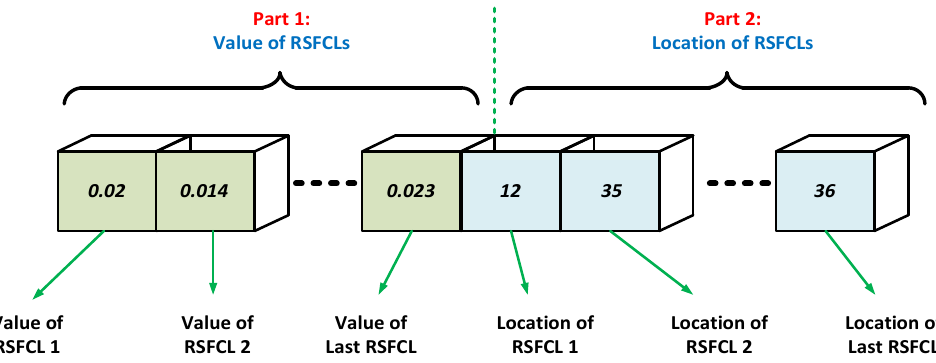
Figure 5. Structure of a typical PSO particle for the proposed problem. According to the flowchart of the proposed PSO-based algorithm in Figure 6, the proposed optimization approach starts with gathering the required data for problem solution including power system data, short-circuit fault data, fault clearing time, number of candidate RSFCLs, bounds of decision variables, and PSO parameters. A random swarm is generated by the PSO algorithm, and then the iteration starts by selecting the first particle. Next, the considered short-circuit fault is applied to the system, and it is cleared after the specified time. In the next step, transient stability analysis is performed for this fault and the objective function of the selected particle is calculated using Equation (7), taking into account the decision variables defined in Equation (8), as well as the constraints presented in Equations (9) to (17). Based on the calculated value for the objective function in the current step and according to the PSO procedure, particles are updated by means of Equations (18) and (19). This process is performed for all of the considered particles in the PSO and for all of the iterations. Finally, the best results calculated by the algorithm are presented as the final solution of the optimization problem. The results of the optimization problem include optimal sizes and optimal locations of the candidate